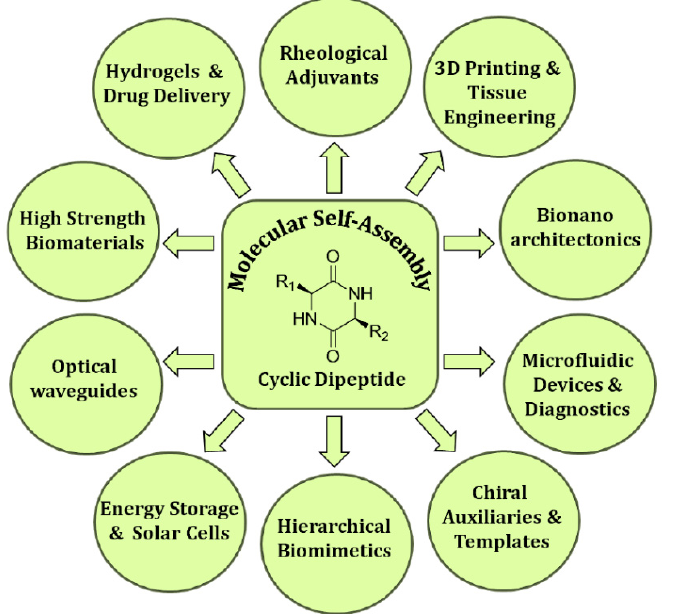
Figure 6. Various applications are envisaged for self-assembled CDPs. Reproduced with permis- sion from [27], © 2017 Wiley-VCH Verlag GmbH & Co. KGaA, Weinheim.